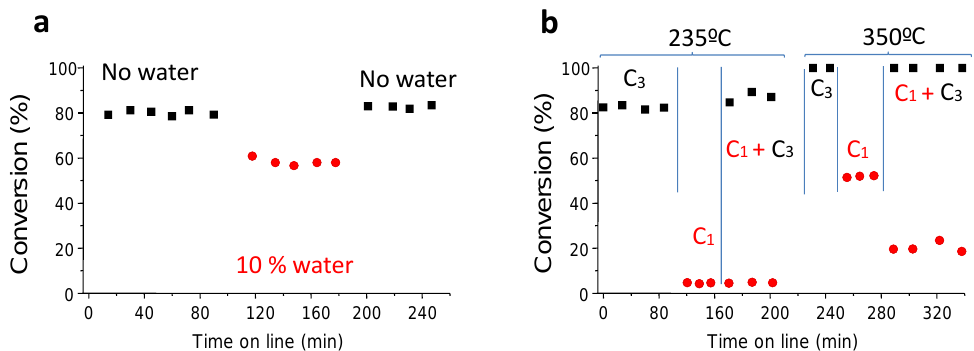
Figure 9. Variations in the propane conversion with the time on line in the absence ( ▪ ) or in the presence of water (●) using Co550 catalyst ( a ). Variations in the propane ( ▪ ) or methane (●) conver- sion with the time on line using Co550 catalyst ( b ). Reaction conditions: ( a ) reaction temperature = 235 °C, C 3 /O 2 /He = 0.8/19.8/79.4 without water or C 3 /O 2 /He/H 2 O = 0.8/17.8/71.4/10 with water; ( b ) first and forth stretch: C 3 /O 2 /He = 0.8/19.8/79.4; second and fifth stretch C 1 /O 2 /He = 0.8/19.8/79.4; third and sixth stretch C 1 /C 3 /O 2 /He = 0.8/0.8/19.7/78.7.